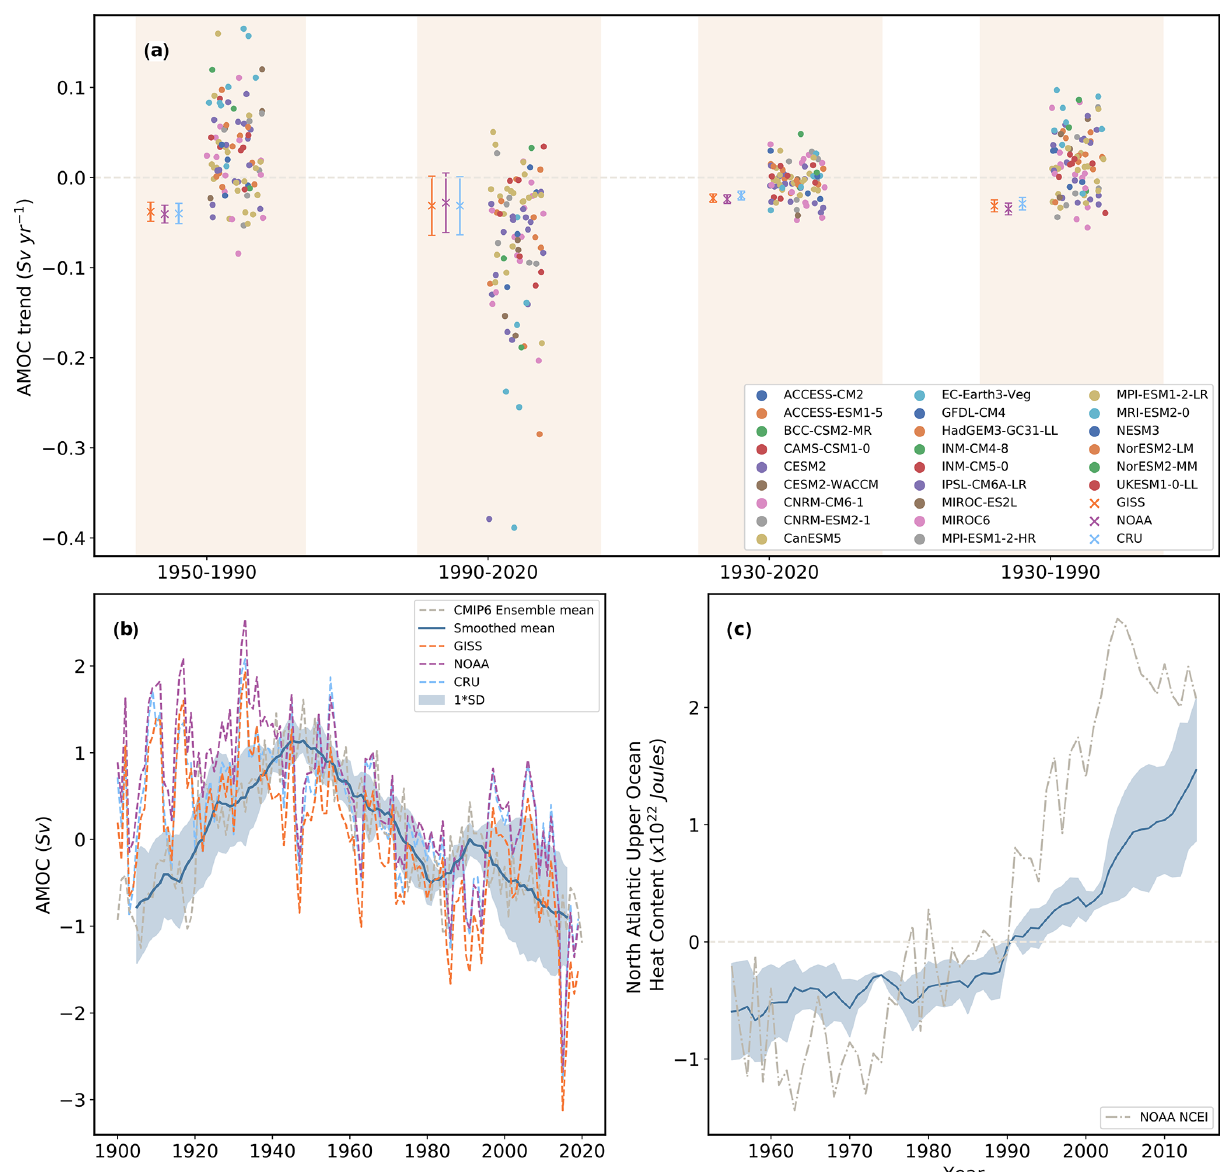
Figure 12. Coupled Model Intercomparison Project phase 6 all forcing annual mean AMOC and OHC for individual model realizations. (a) AMOC trends [Svyr − 1 ] are shown for four time periods, including 1950–1990, 1990–2020, 1930–2020, and 1930–1990. Each individual model realization is shown with a symbol. Also included (crosses) are the corresponding inferred AMOC trends (ending in 2019) based on surface temperature observations. Error bars on inferred AMOC trends represent the 95% confidence interval of the trend. (b) Ensemble mean annual mean normalized AMOC [Sv] time series (dashed gray line) and 10-year running mean (solid blue line) based on the two CMIP6 models (CanESM5 and IPSL-CM6A-LR; five realizations in total) that yield AMOC trends that fall within the observational uncertainty for all four time periods. Blue shading shows the corresponding inter-model standard deviation. Also included are the three inferred AMOC time series, which are based on surface temperature observations. (c) The same as in (b) but for the 1955–2014 North Atlantic upper-ocean (0–700m) ocean heat content (OHC). Also included in (c) is the corresponding observed OHC (gray dashed line) from the NOAA National Centers for Environmental Information (NOAA